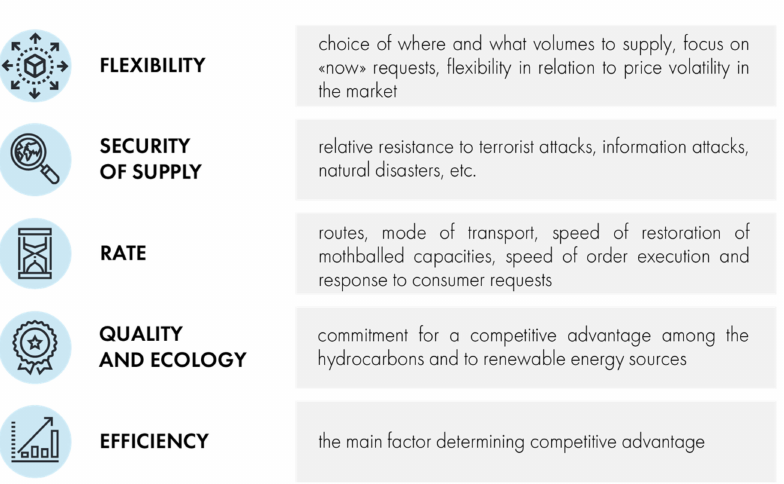
Figure 3. Properties of the sustainable development of fossil energy